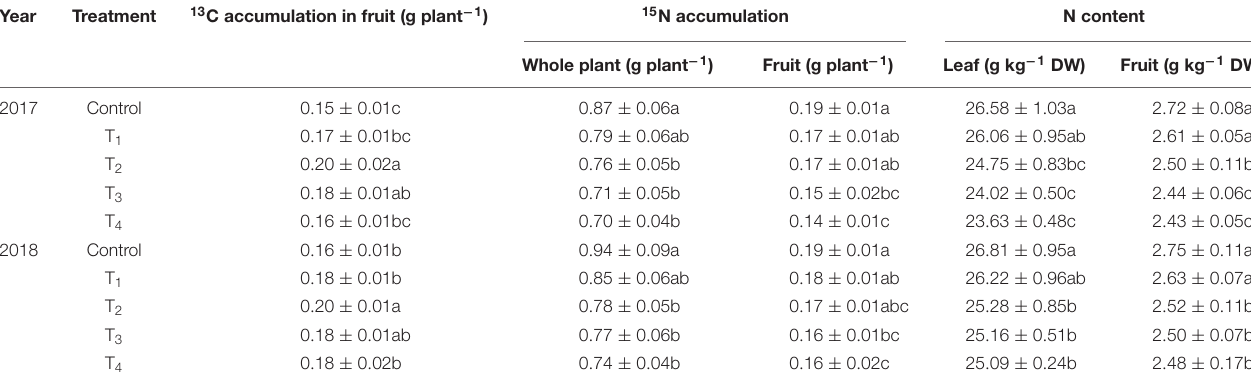
TABLE 3 | Effects of DMPP on plant C–N nutrition. Year Treatment